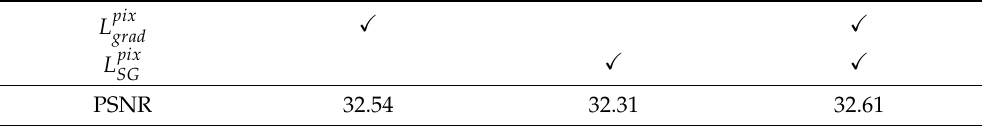
Table 2. Ablation experiments on gradient-guided loss, including L pix values are evaluated on Set5 dataset with scaling factor ×